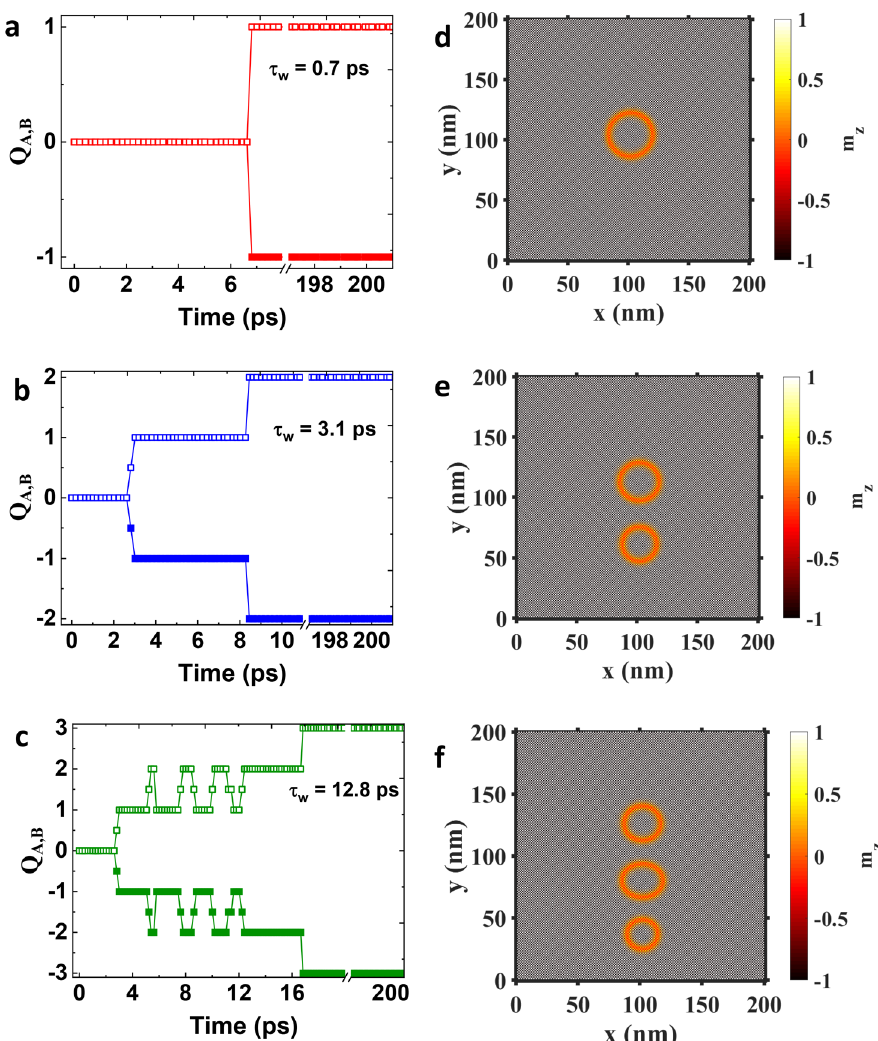
Figure 4. Left figures ( a – c ) show the evolution of topological charge for the AFM skyrmion sub-lattices A (open symbols) and sub-lattice B (closed symbols) for three different pulse widths ( τ w 3 10 13 A/m 2 ) . Right figures ( d – f ) show the corresponding snapshots of for a constant current density ( J x , z = × AFM skyrmions at 200 ps for each case.